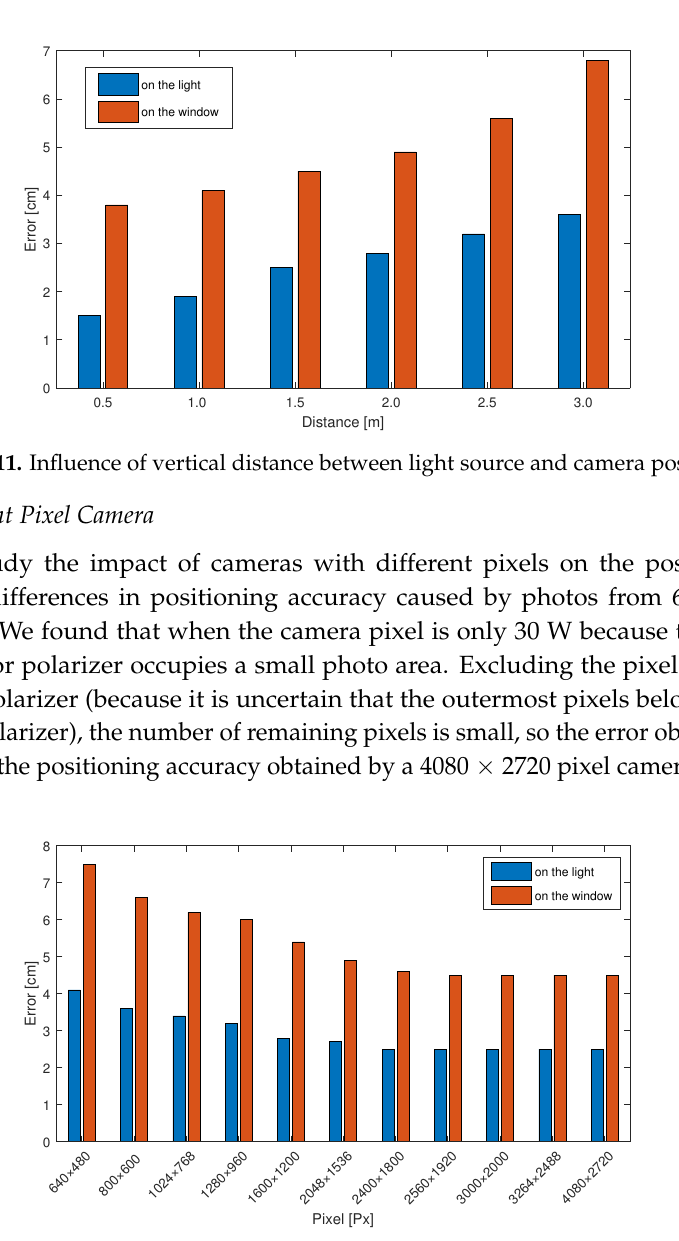
Figure 12. Influence of different pixel camera on positioning